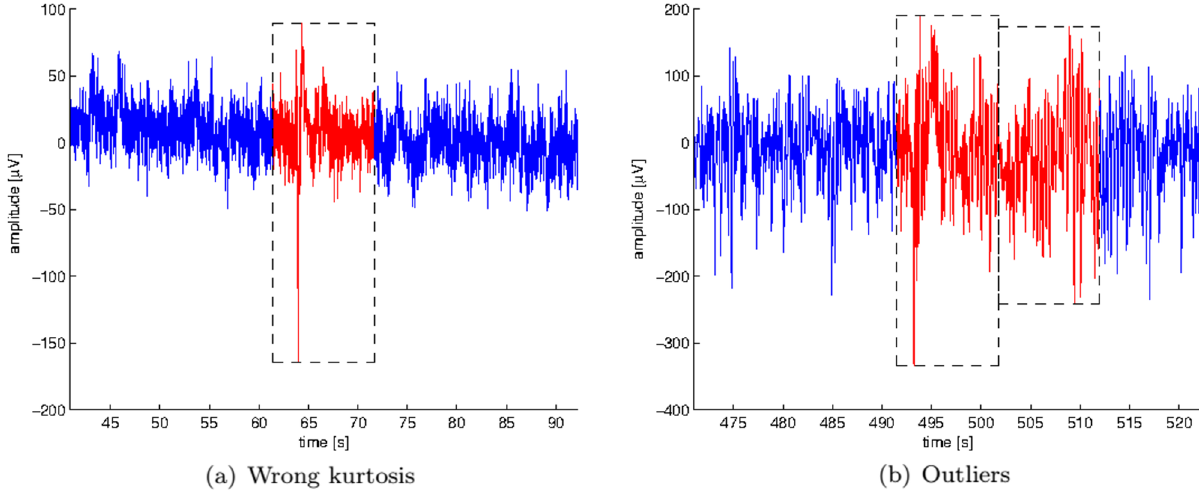
Fig 1. Epochs automatically marked to be rejected. The picture shows (a) one epoch(in red) of the first channelof one recordedEEG signal that does not satisfy the limits for kurtosis ( rejkurt )used to identify background EEG signal; and (b) two epochs of the second channelof one recorded EEG signalthat probably( jointprob ) do not belongto background EEG signal.